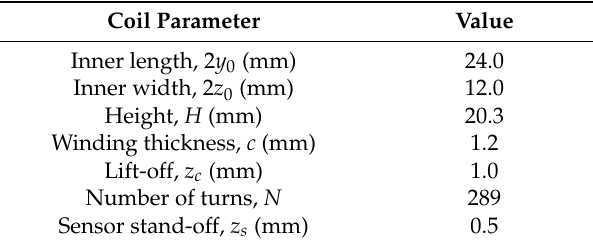
Table 1. Parameters of the probe.